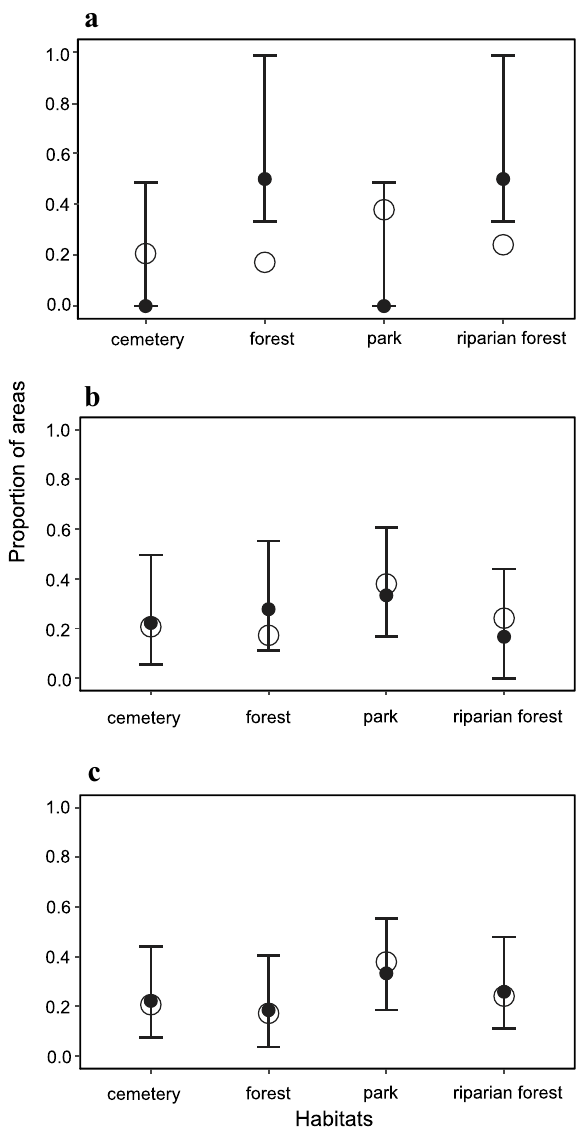
Figure 4. Proportion of green areas occupied by the red fox as confirmed by snow tracking, attributed to four habitat types in Warsaw, in subsequent study periods: ( a ) 1976–1978 (Goszczyński J., unpbl. data), ( b ) 2004–2012 and ( c ) 2016–2019. A full circle indicates actual proportion and an empty circle indicates expected proportion of colonized areas attributed to a certain habitat type, bars depict lower and upper bound of the confidence